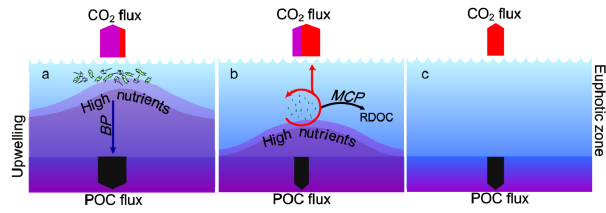
Fig. 7. Scenario models for the effects of upwelling on ocean car- bon uptake/outgassing dynamics. Note the scenarios assume steady state of a water body without advective exchanges at horizontal di- mensions. Red arrows indicate respiration flux; pink arrows indicate DIC release from deep water. (a) Scenario of POC export flux ex- ceeding total CO 2 flux: nutrients are injected into the upper layer of the euphotic zone; diatoms are dominant; POC export exceeds CO 2 outgassing; the biological pump is the prevailing mechanism for carbon sequestration. (b) Scenario of total CO 2 flux exceeding POC export flux: nutrients are injected only into the lower layer of the euphotic zone; Prochlorococcus are dominant; microbial respi- ration is mobilized; CO 2 outgassing exceeds POC export; the MCP is the prevailing mechanism for carbon sequestration. (c) A non- upwelling scenario for reference.